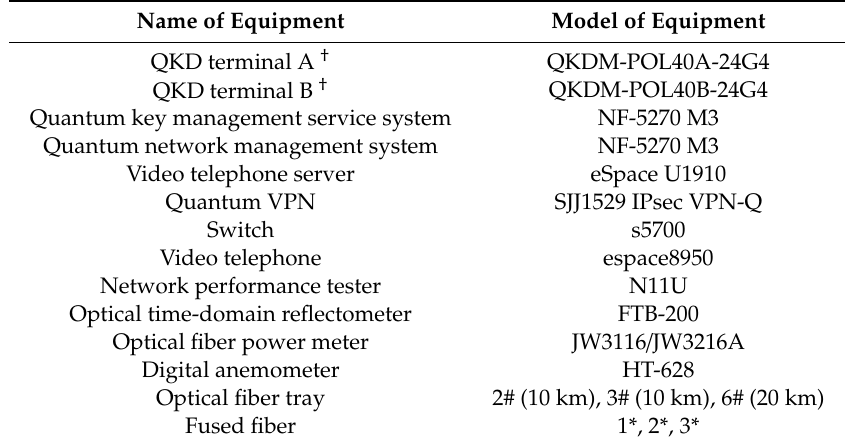
Figure 3. The network topology of the test environment. Table 3. Experimental equipment.